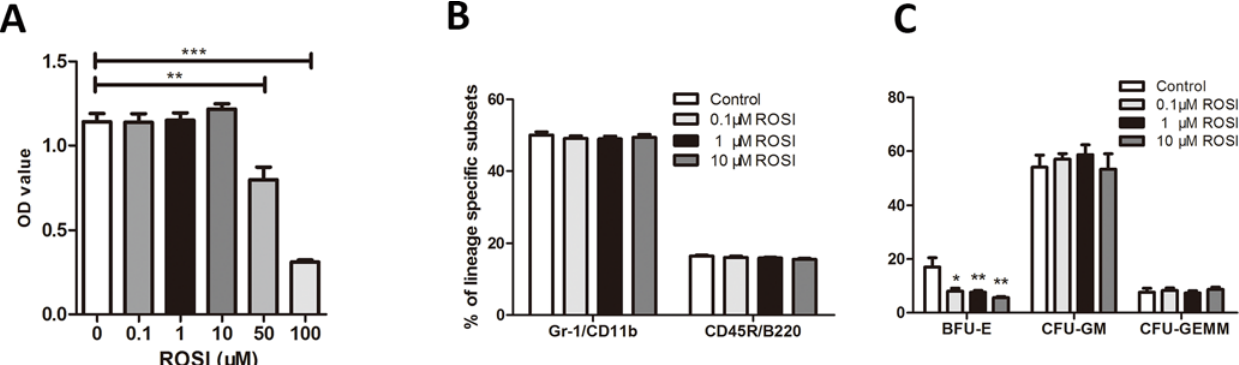
Fig 6. Rosiglitazone has no effect on hematopoietic progenitor cells in vitro . Lin - cells from the BM of 5-Fu-treated mice were selected and cultured in the presence or absence of rosiglitazone for 7 days, and the cell proliferation, cell phenotype and colony-forming potential of Lin - cells were assayed. The data are presented as the means ± SD of three independent experiments, ** P < 0.01 compared to control, *** P < 0.001compared to